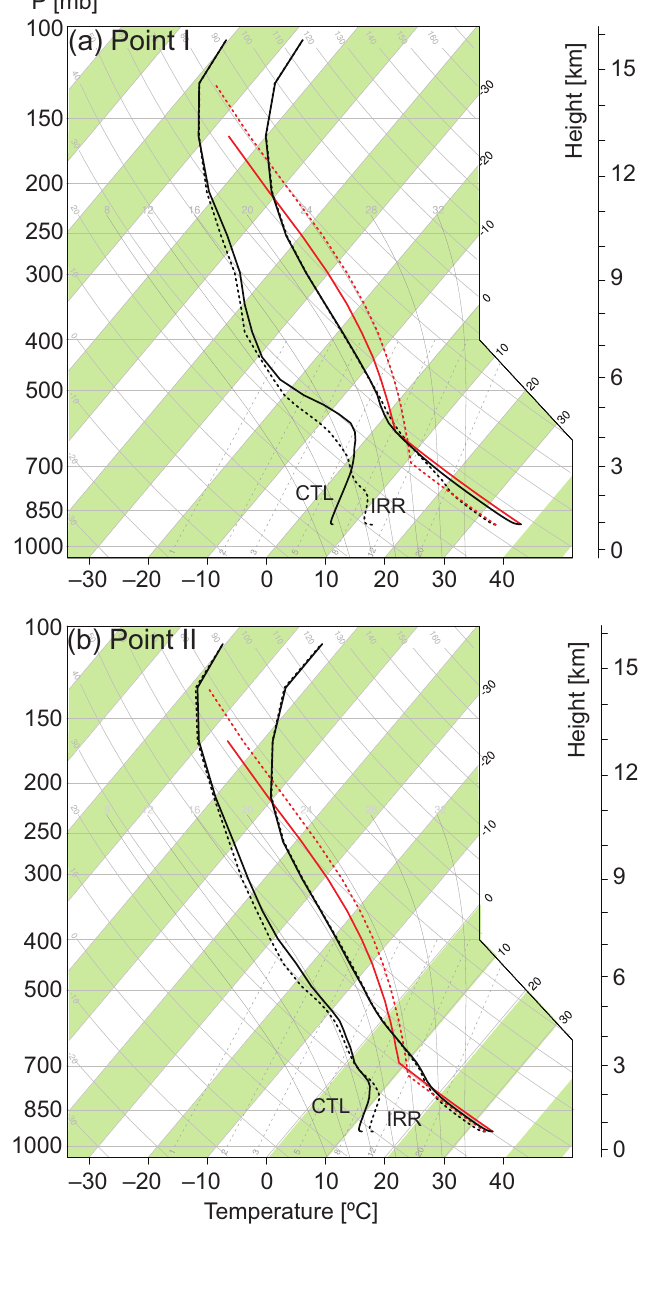
Figure 6. Skew-T log-P diagrams corresponding to ( a ) Point I and ( b ) Point II, as denoted in Figure 1. On each sounding are plotted monthly mean 2200 UTC simulated temperature and dew point temperature (both in ◦ C) for the CTL (solid black lines) and IRR (dotted black lines) simulations. Red lines represent thermodynamic paths of hypothetical surface-based